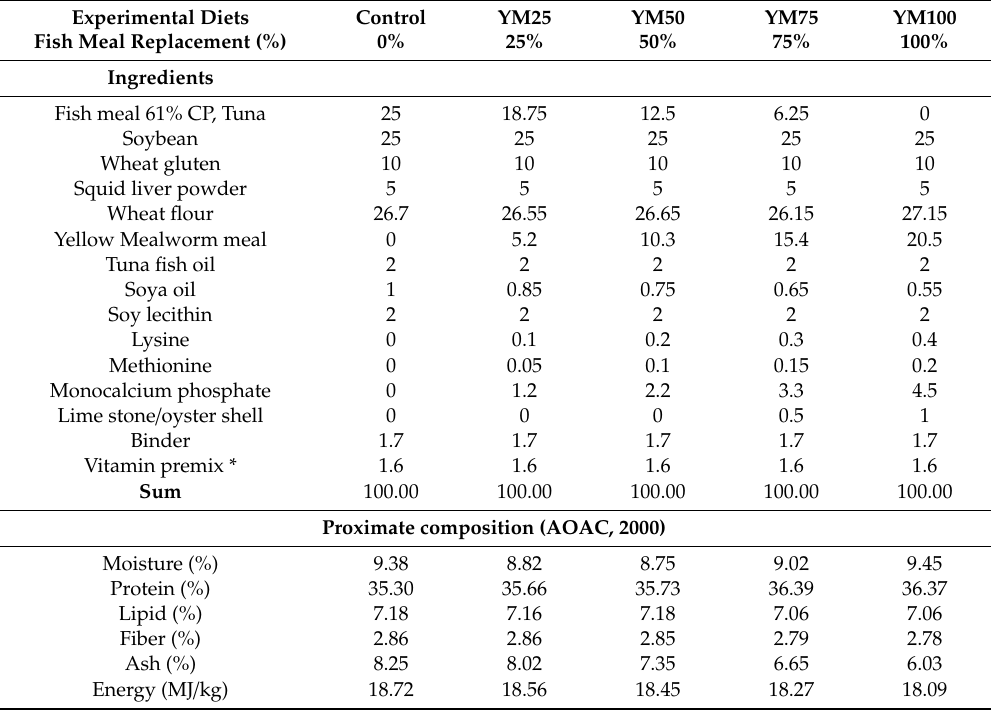
Table 2. Experimental diets formulation and proximate composition (% Dry Weight). Experimental Diets Fish Meal Replacement (%)